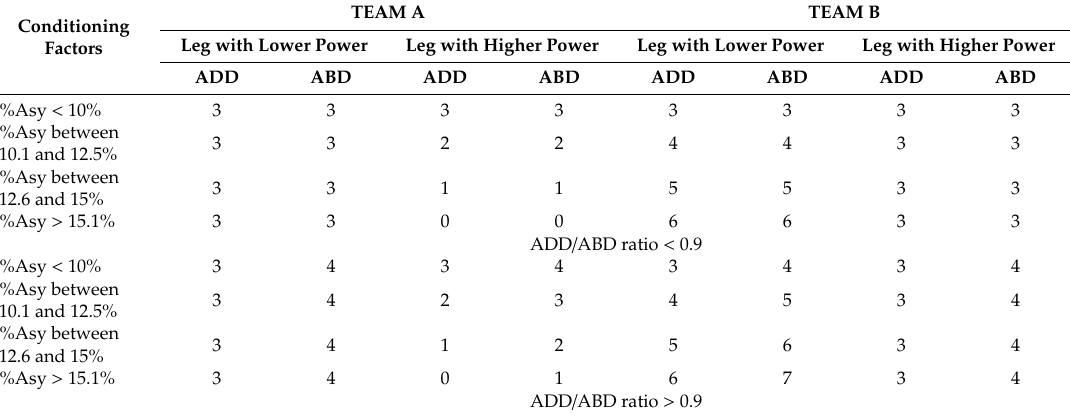
Table 1. The adductor injury prevention program volume (sets) based on unilateral deficit (%Asy) and adductor / abductor ratio (ADD / ABD ratio) output during the last measurement for TEAM A and TEAM